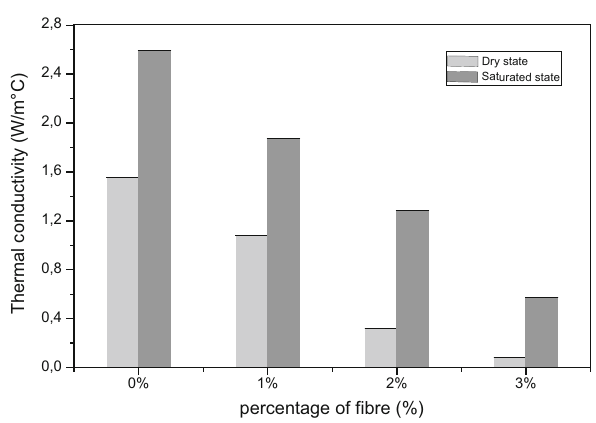
Fig. 4 Thermal conductivity of lightened concrete as function of density at dry state and saturated state